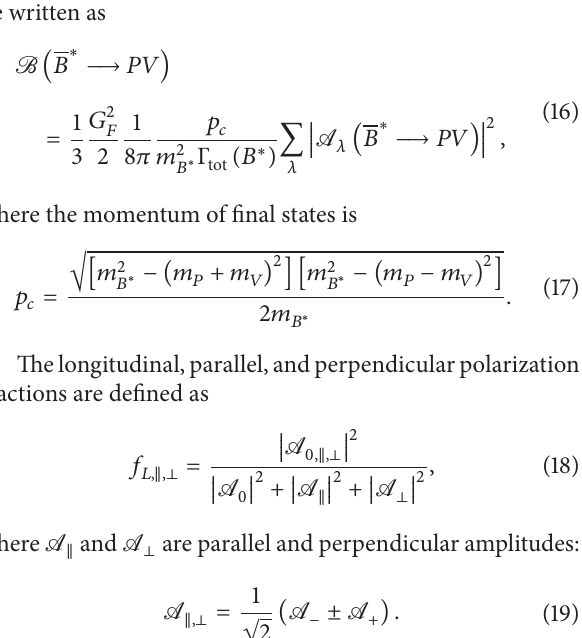
Table 1: The numerical results of form factors within BSW